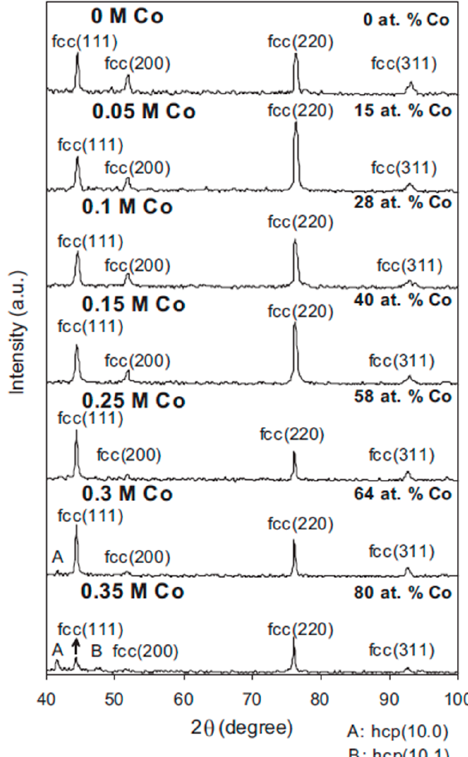
Figure 7. X-Ray diffraction (XRD) patterns of Ni–Co films deposited from the electrolytes containing different Co concentrations [68]. Reprinted from Applied Surface Science, 258, Ali Karpuz, Hakan